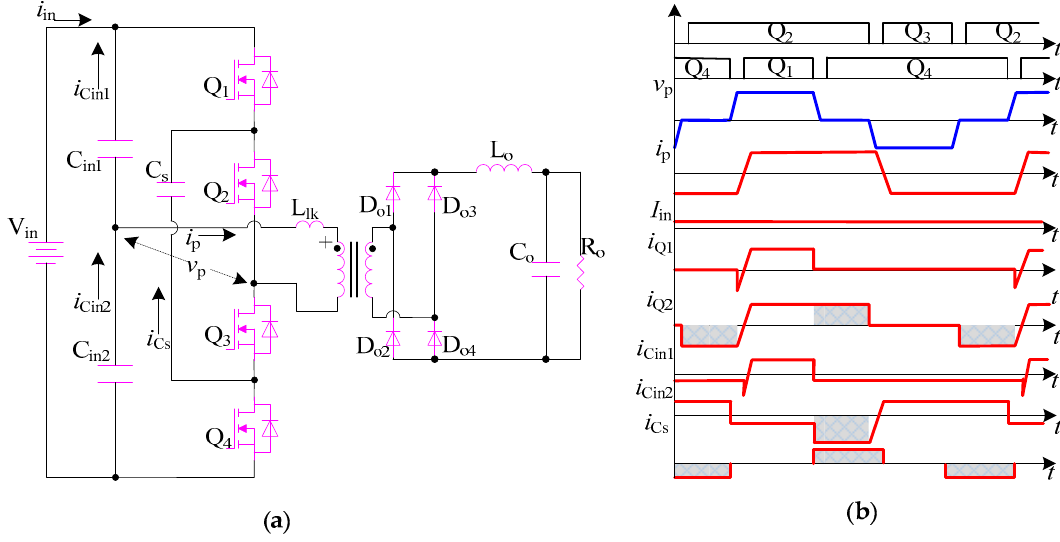
Figure 1. Capacitor-clamped HB TLDC and its key waveforms: ( a ) Circuit; ( b ) Key waveforms.